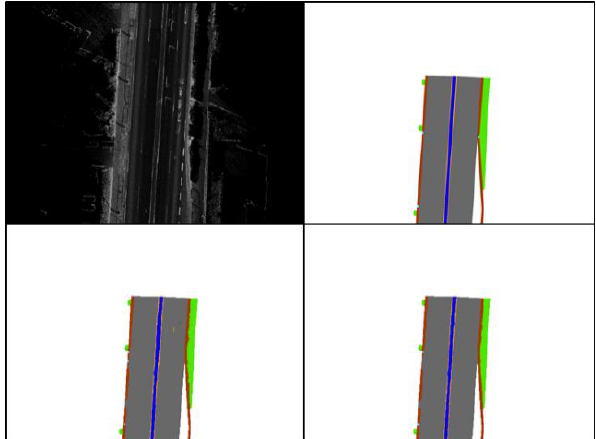
Figure 8. Example of our labeling results. Upper left: input image. Upper right: ground truth label. Lower left: only 48×48 pixels. Lower right: combination of 64×64 pixels and 48×48 pixels.